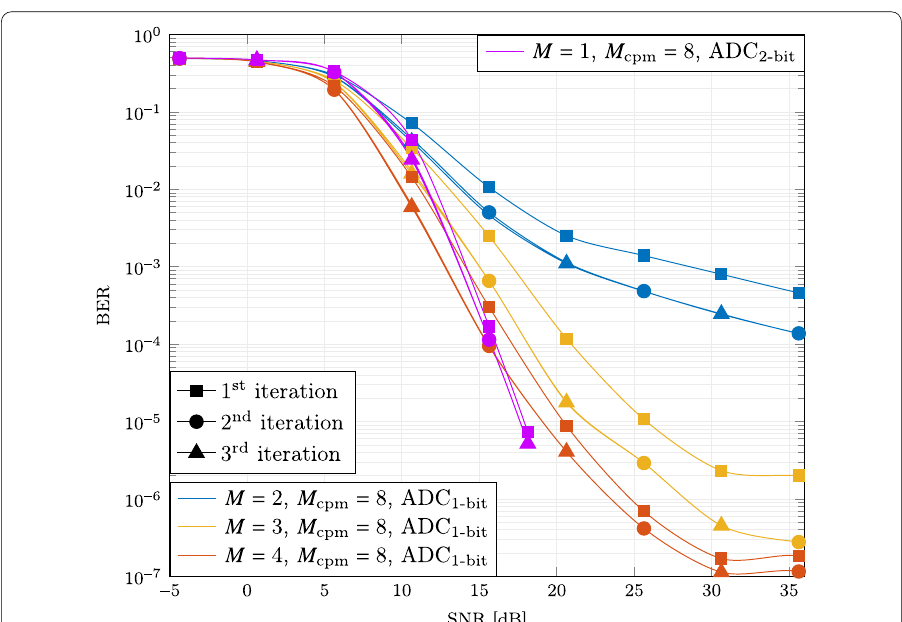
Fig. 10 BER results for the considered CPM system using different oversampling factors, channel code with rate 1/3 and Gray mapping